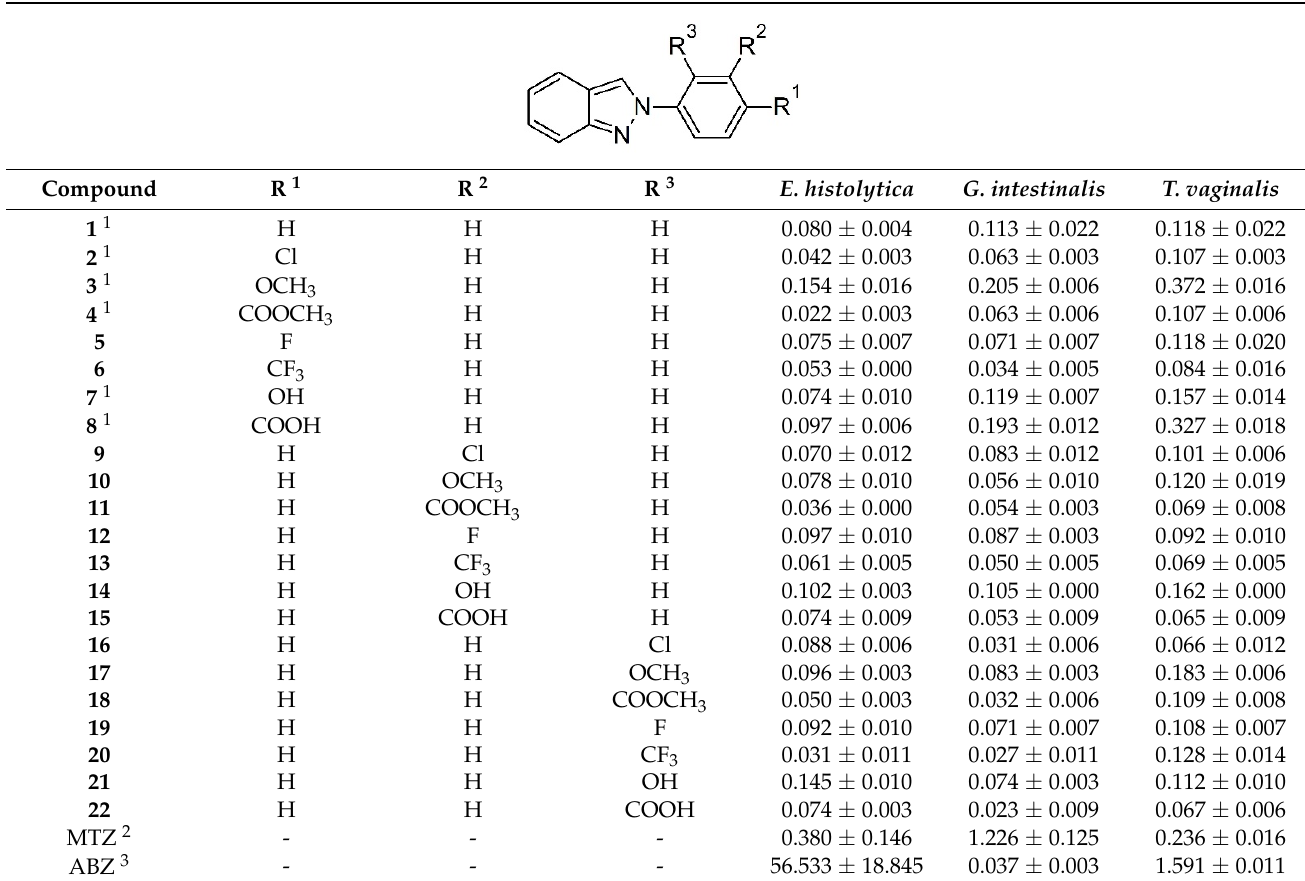
Table 2. Antiprotozoal activity of the 2-pheny-2 H -indazole derivatives synthesized (IC 50 [ µ M] ± SD).